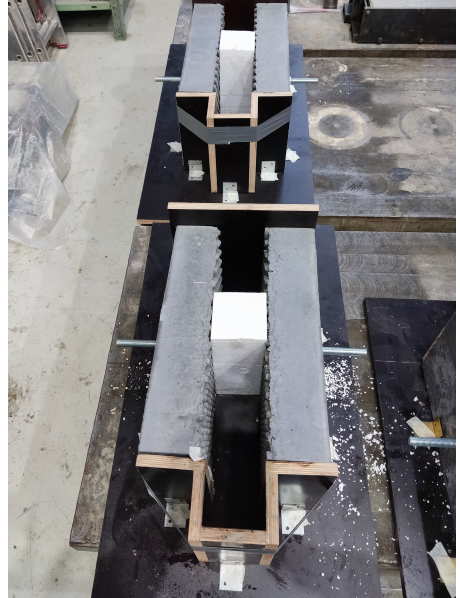
Figure 4. Sandwich samples prepared to be filled with NSC between two UHPC